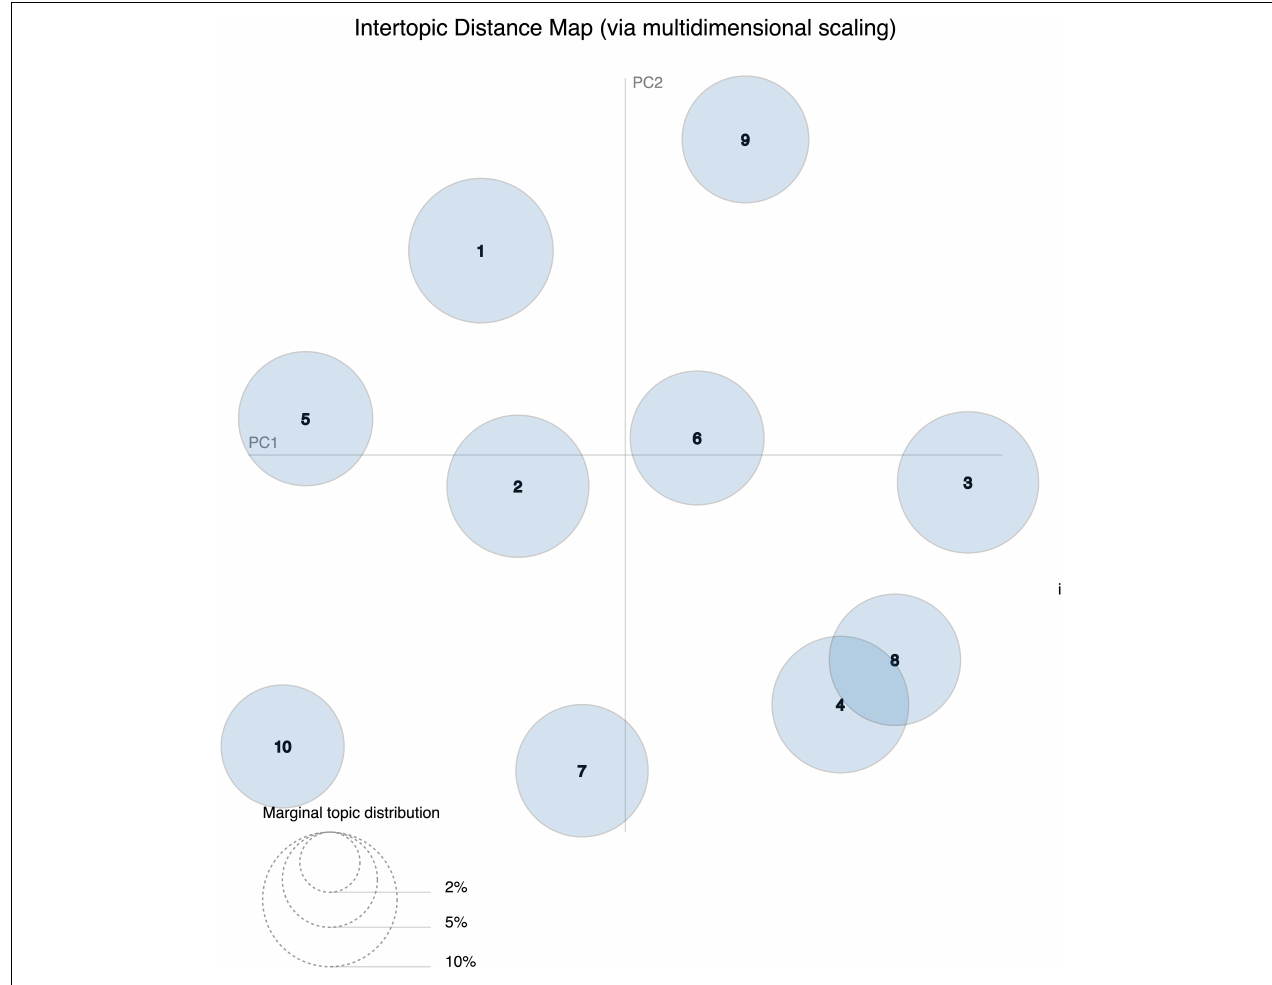
FIGURE 6 | Intertopic distance map ( N = 10 topics, retweets excluded). PC, principal